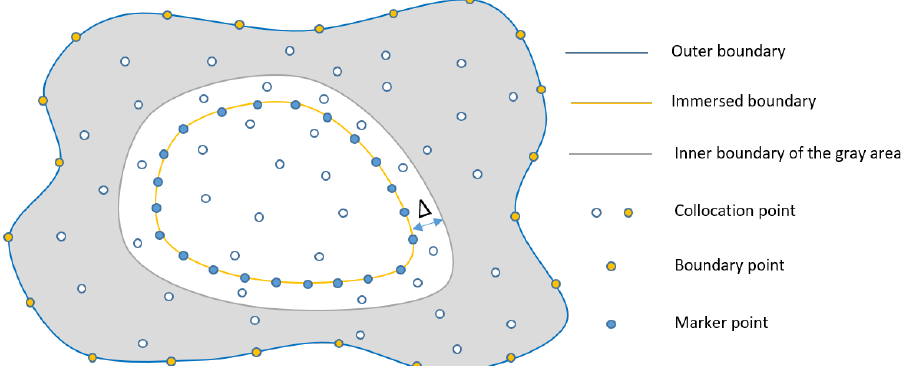
Figure 2. A schematic diagram of the computational domain, the outer boundary and the locations of three sets of points required in computing the loss function of IB-PINN. The force penalties are imposed at the collocation points which are located inside the gray area. The distance from the inner boundary of the gray area to the immersed boundary is ∆